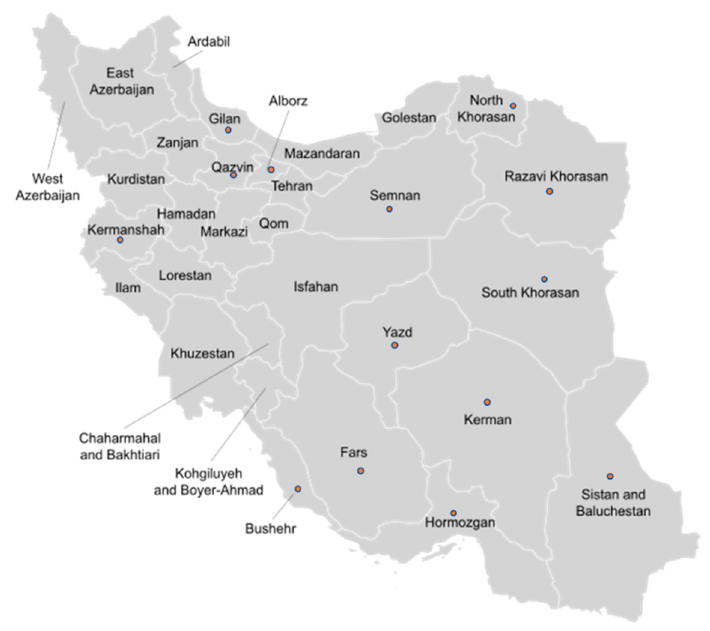
Figure 1. Provinces under study in this work.